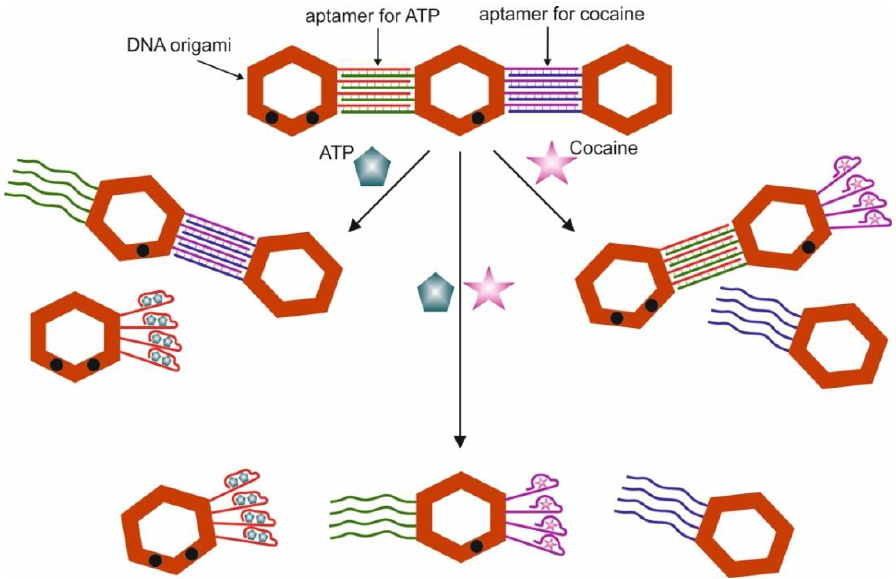
Figure 22. Logic scheme adapted from Reference [159] with permission from The Royal Society of Chemistry. ATP = adenosine triphosphate.